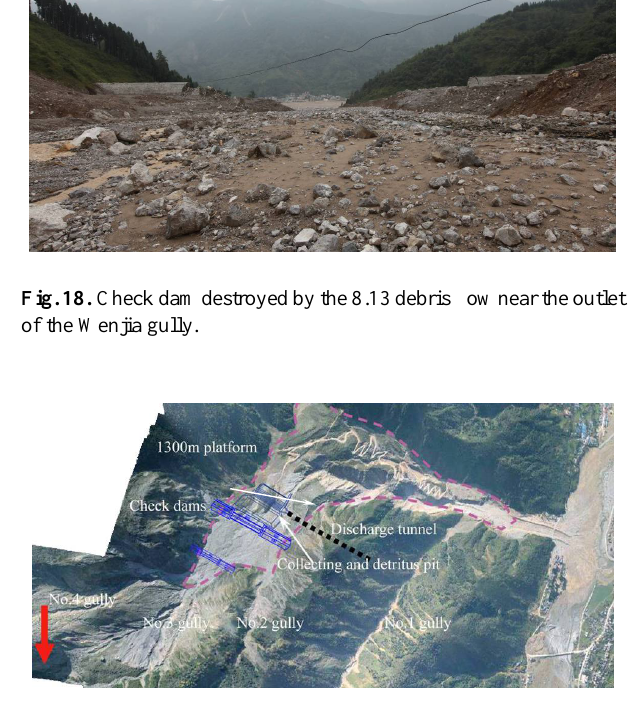
Fig. 22. A flexible erosion prevention system constructed in the Wenjia gully.